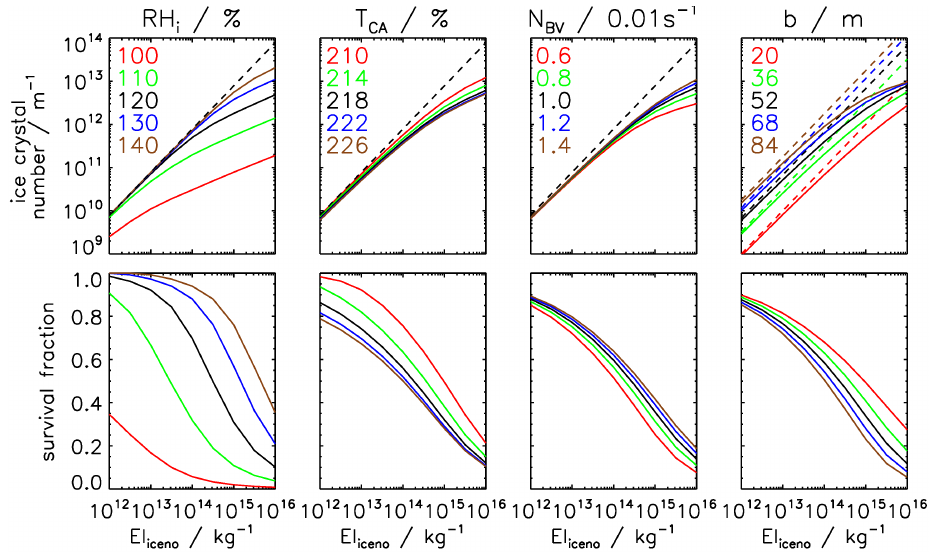
Figure 9. Sensitivity of ice crystal loss to EI iceno for various values of RH i , T , N BV and b (from left to right). See legend for the colour coding. Top row: ice crystal number per metre of flight path before and after the vortex phase (dashed and solid curves). Note that the initial ice crystal number depends only on b and EI iceno (following Eq. A10). Hence, only one dashed curve is shown in the columns for RH i , T and N BV , respectively. Bottom row: survival